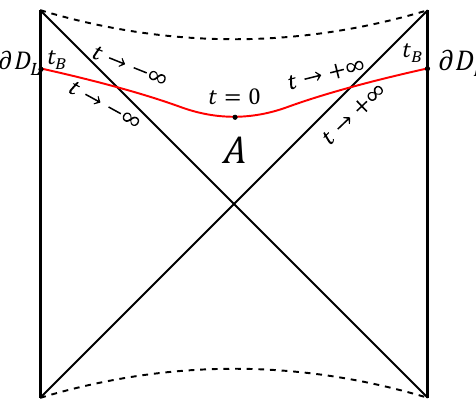
Figure 2 . Set t R = − t L = t B . A is the middle point with t = 0